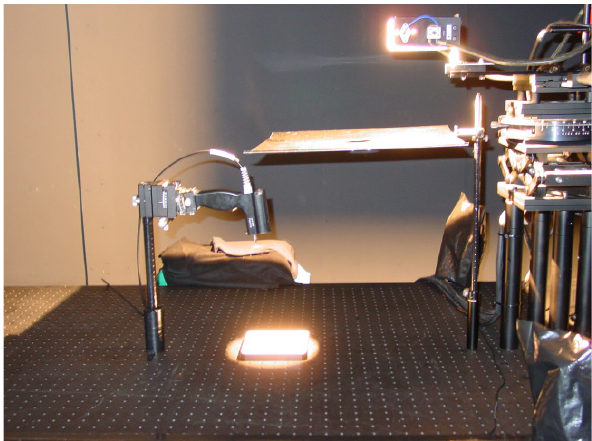
Figure 5. The reflectance measurement of the Spectralon reference plate with the ASD FieldSpec Pro Jr spectroradiometer. The refer- ence plate in placed on the table, and the fibre optic cable is attached to the pistol grip fixed to the table in order to measure the reflected lamp radiation. The lamp is attached to the holder in the top right